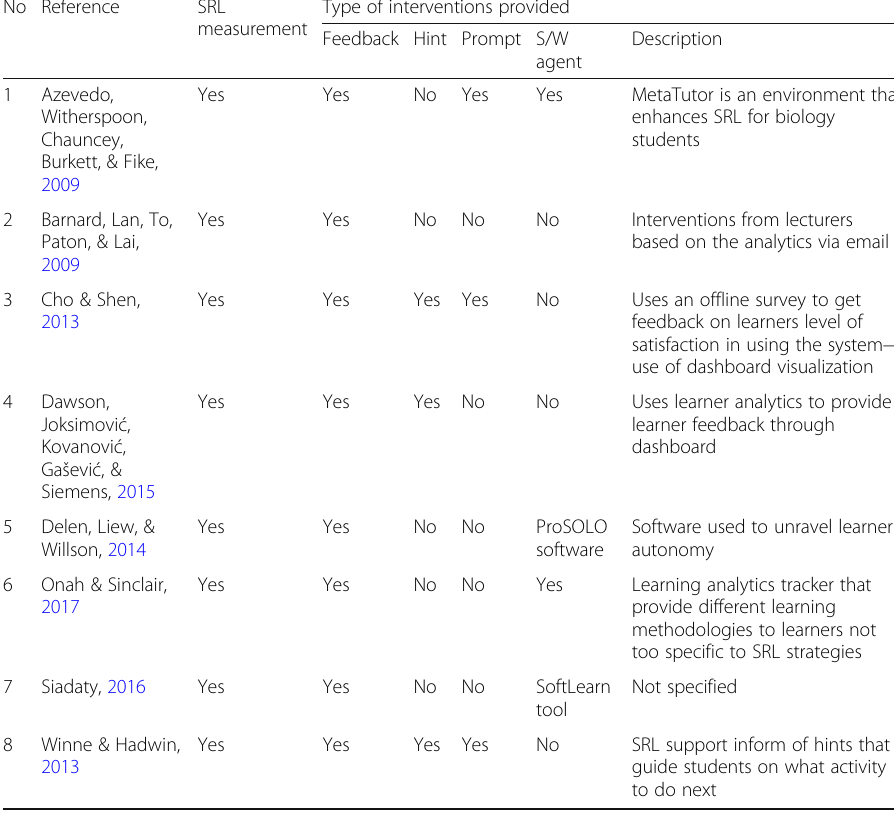
Table 2 SRL measurement tools that also acted as intervention tools No Reference SRL Type of interventions measurement